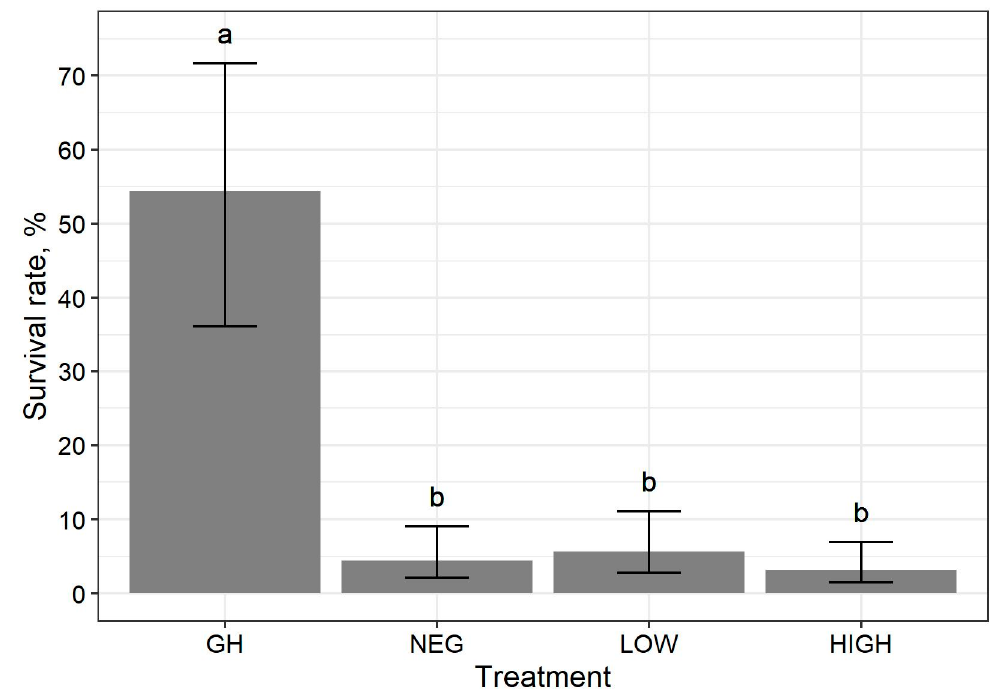
Figure 2. Mean survival rates ( ± 95% CI) of face fly ( Musca autumnalis De Geer) larva reared in cow dung pats under different treatment conditions. Treatment means with a different letter are different at p ≤ 0.05. Treatments: GH = greenhouse; NEG = on pasture without broilers; LOW = on pasture with low density broilers (2.5 m 2 outdoor area per bird; HIGH = on pasture with high density broilers (0.5 m 2 outdoor area per bird).